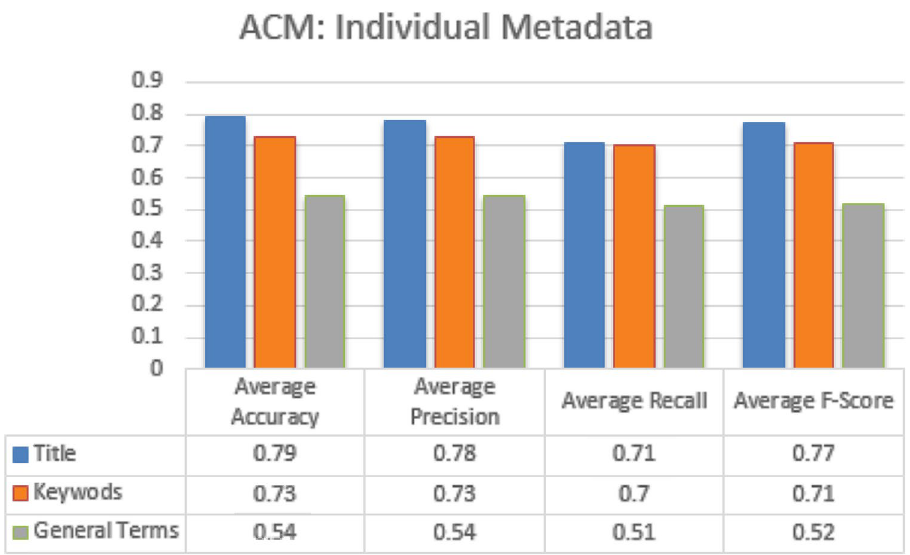
Figure 9. ACM (individual